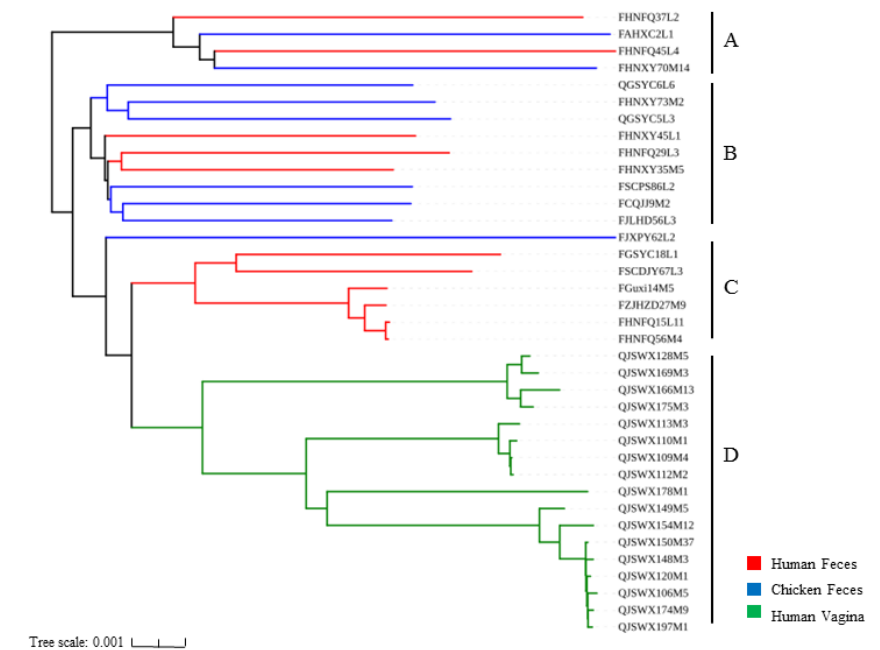
Figure 4. Phylogenetic tree of 37 L. crispatus strains. Based on 1091 single-copy core genes of 37 strains, the phylogenetic tree was constructed using the neighbor-joining method.